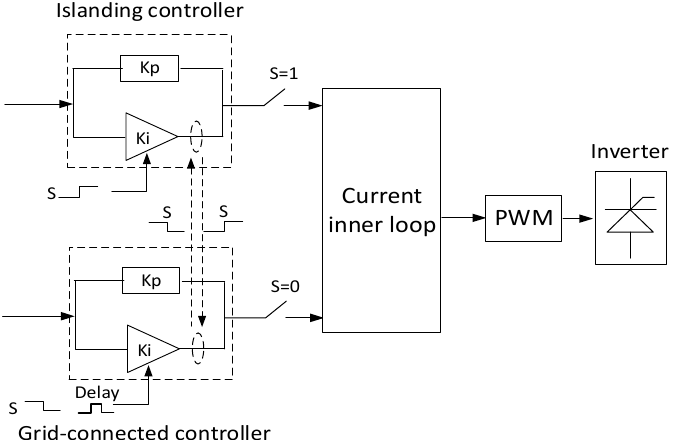
Figure 8. Scheme of islanding signal-based control.